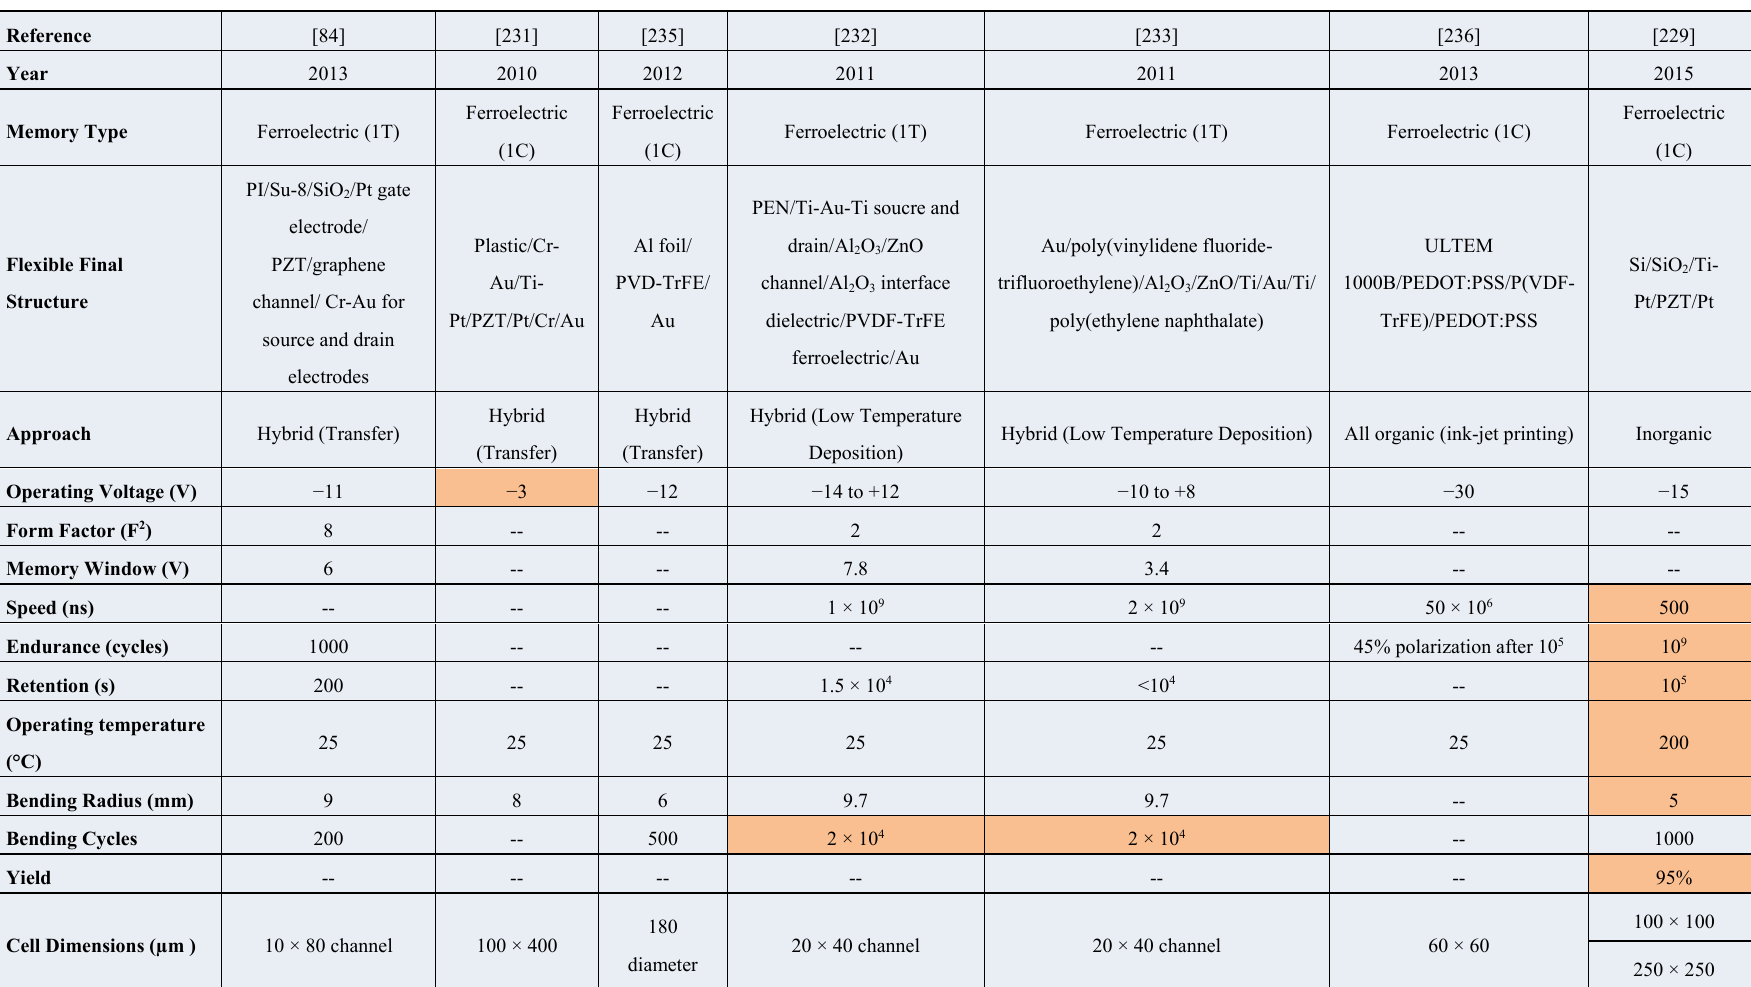
Table 6. Summary of the key works on flexible ferroelectric random access memories (FeRAM) over the past five